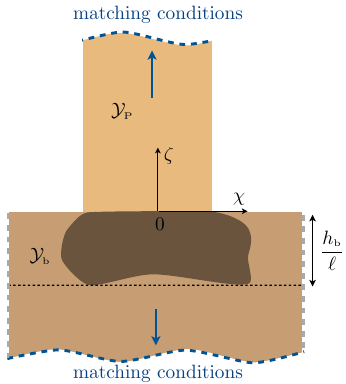
Figure A3. Elementary cell at the bottom of a single plate in the χ = ( χ , ζ ) coordinate. Y = ( 0, + ∞ ) χ with P × Y P { ∈ of the heterogeneity of vertical extent h